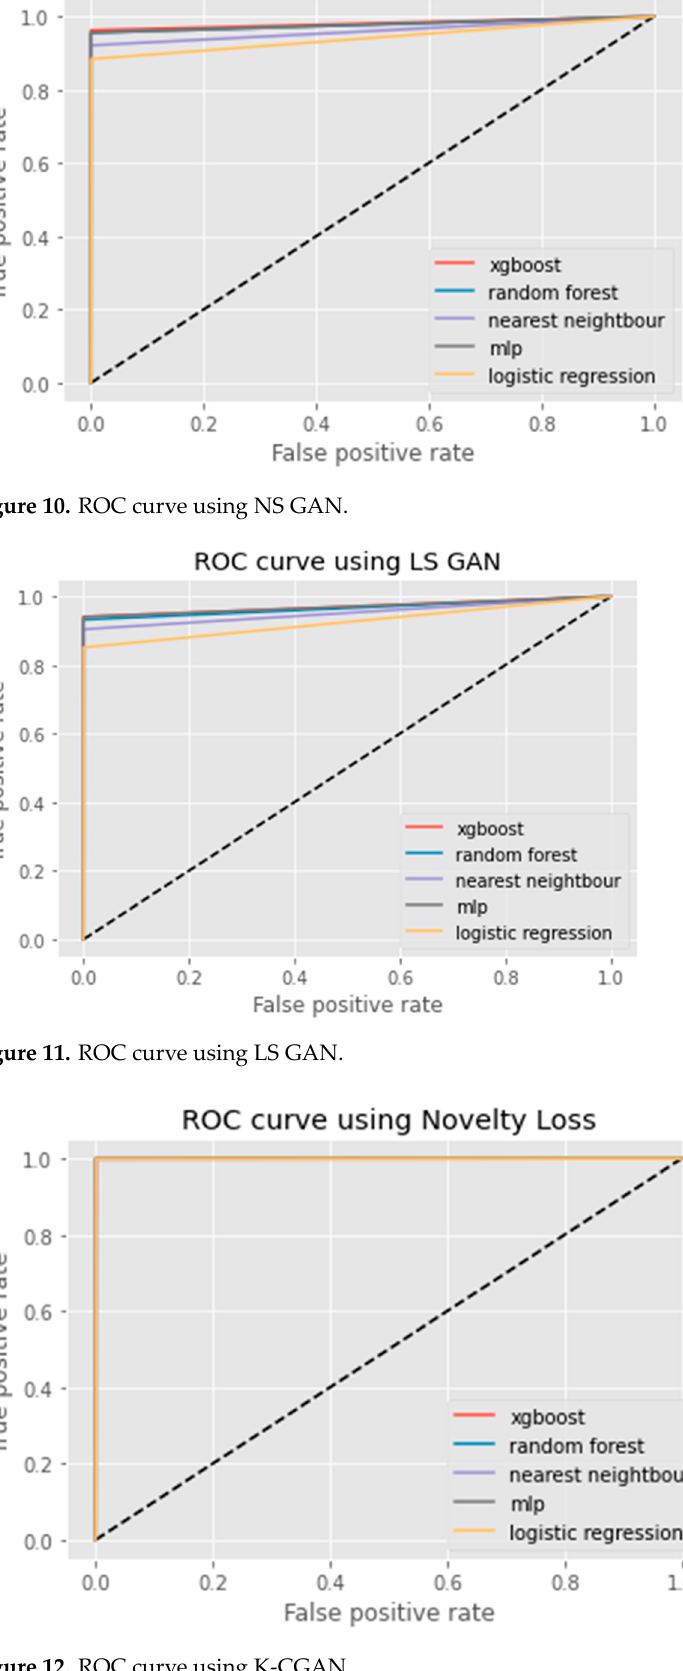
Figure 12. ROC curve using K-CGAN.